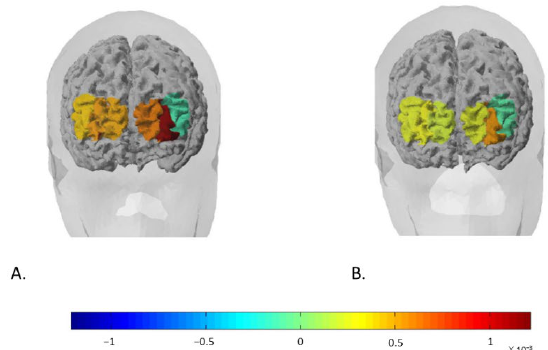
Figure 3. Rendering representation of cortical activity. The cortical maps show the modifications of O2Hb levels as a function of the type of commercials viewed by ( A ) the experimental group (COVID-19-related ads) and ( B ) the control group (ads unrelated to COVID-19). Finally, a significant interaction effect between Group and Channel was found (F [5,18] = 7.08, p = 0 .01, η 2 = 0.395). Pairwise comparisons revealed that the D values in Chan- nel 1 were significantly higher than those in Channel 3 only in the COVID-19-related con- dition (F [1,18] = 9.77, p = 0.0 1, η 2 = 0.498) (Figure 3). Conversely, statistical analysis for the HHb mean values yielded no significant ef- fects. About the correlational analysis, firstly, the brand engagement and the intention to purchase did not correlate when considering the two groups individually (COVID: r = −0 .173, p > 0.5); non-COVID: r = 0.623, p = 0.54). However, a positive correlation was found between brand engagement and purchase intention only when taking into account the whole sample ( r = 0.576, p = 0.008). Specifically, high levels of brand engagement correlate with high levels of purchase intention, regardless of the type of advertising viewed (Fig- ure 4).